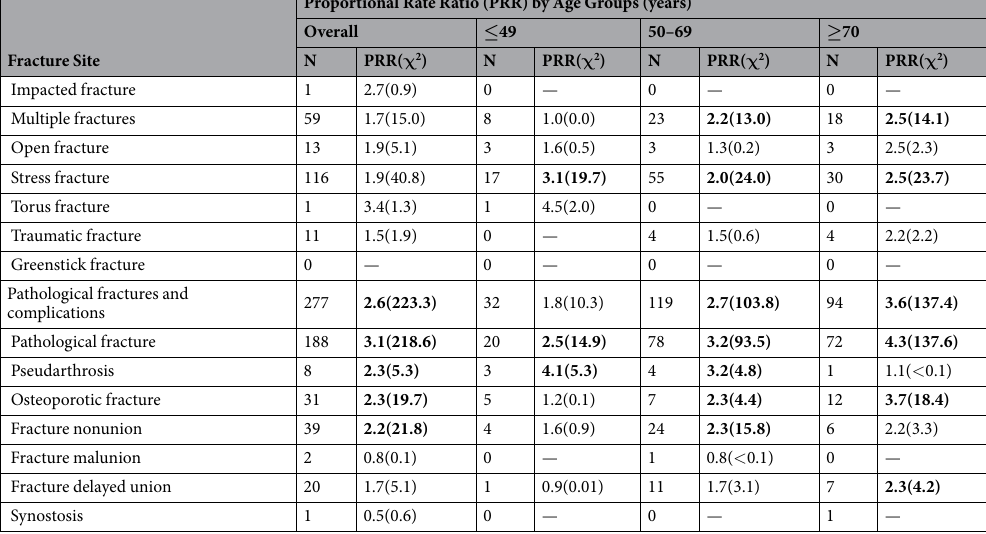
— — — Table 2. Signal detection between any proton pump inhibitor (PPI) and reported fracture adverse events as classified by MedDRA’s 8 High Level Terms (HLT) and corresponding 61 Preferred Terms (PT), by overall and age groups. Around 82% of reports have age information. Bold indicates statistically significant